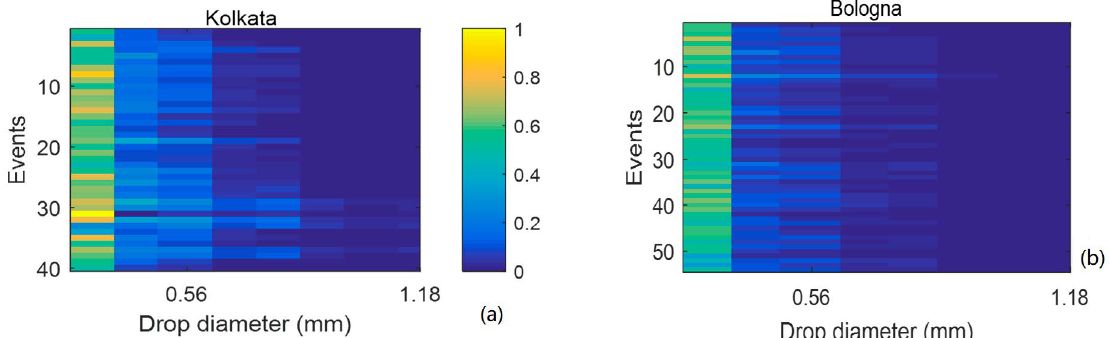
Figure 9. Fraction of super-terminal drops in the rain events in ( a ) Kolkata and ( b ) Bologna. The color bar represents the fraction of drops. The x-axis represents the drop diameters binned by Parsivel2 classes, whereas the y-axis shows the different events for each site.